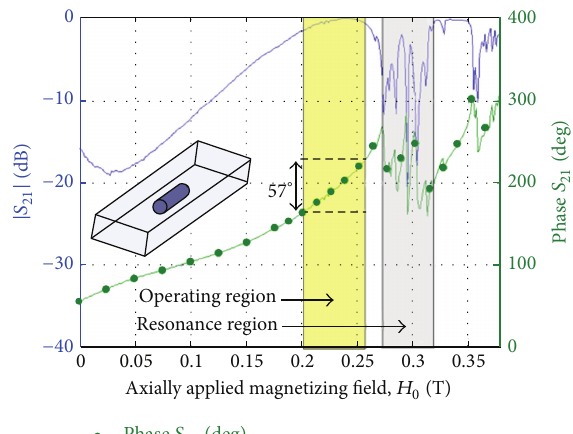
Figure 2: Magnitude and phase of the transmitted signal through a ferrite cylinder when excited by plane waves in a rectangular